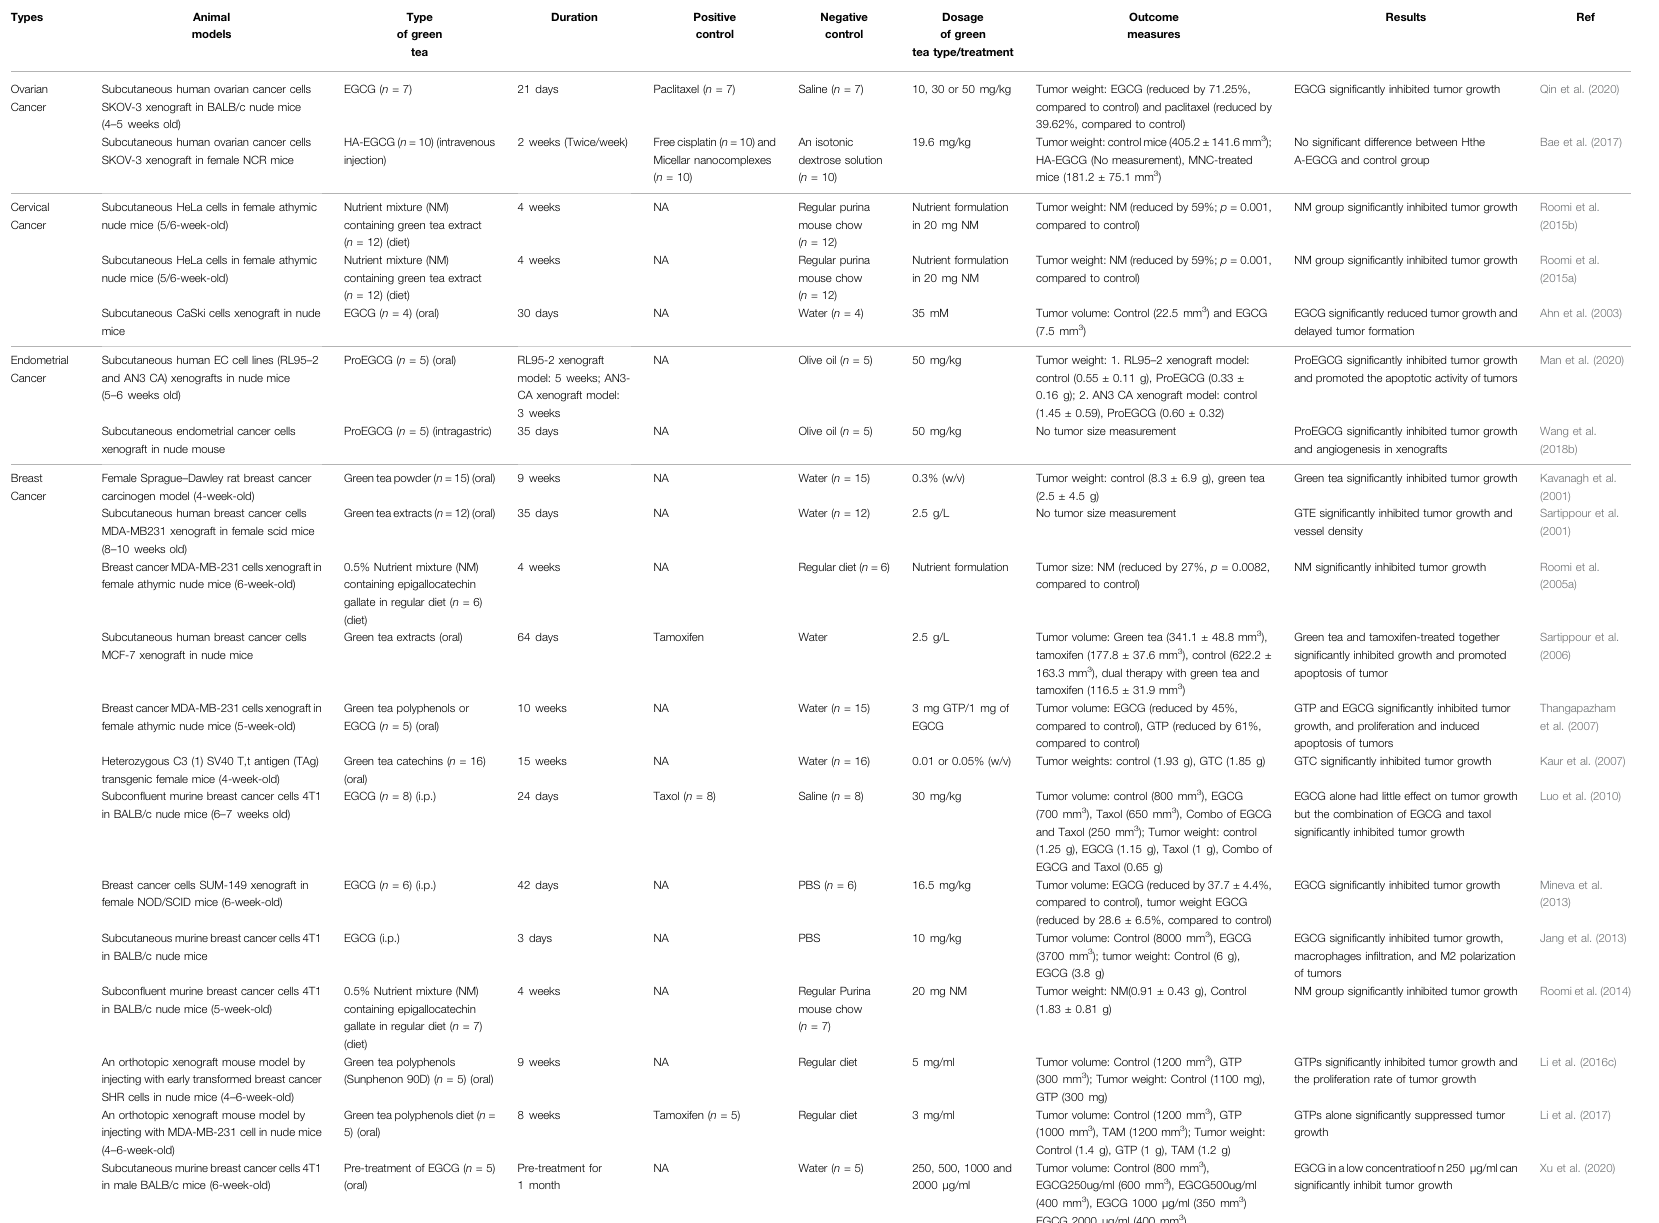
TABLE 2 | Effects of Green tea on reproductive cancers in animal models.